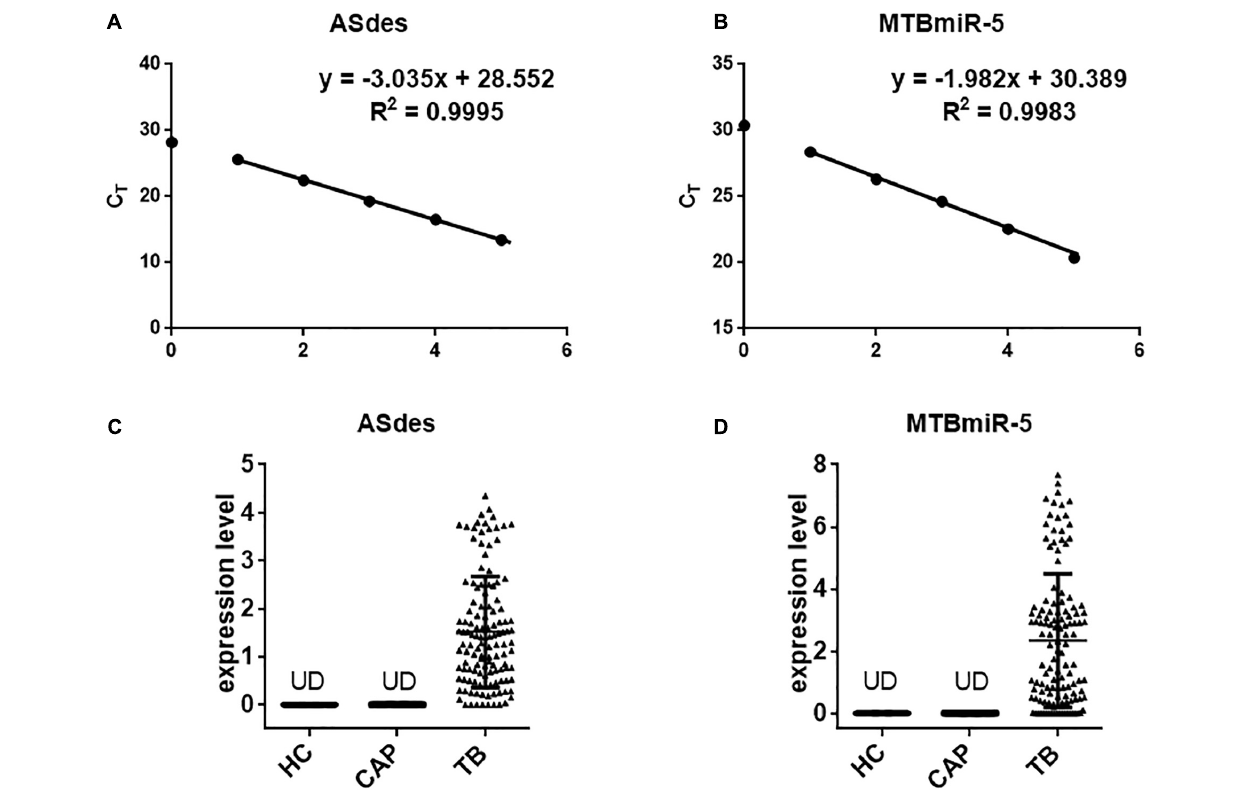
FIGURE 2 | The changes in concentrations of serum exosomal M. tuberculosis -encoded ASdes and MTB-miR5. (A,B) Dynamic range and sensitivity of the qRT-PCR assay for measuring ASdes (A) and MTB-miR5 (B) . Synthetic single-stranded sRNA was serially diluted over several orders of magnitude to levels ranging from 10 attomole to 105 attomole and assessed by the qRT-PCR assay. The resulting CT values were plotted against the index with base 10 of the amount of input sRNA to generate a standard curve. An assay using water instead of RNA for the qRT-PCR assay was included as a no-template control. (C,D) The expression level (pmol per 1 L of serum) of ASdes (C) and MTB-miR5 (D) in the small extracellular vesicle isolated from serum of healthy controls (HC), active pulmonary TB patients (TB) and community acquired pneumonia (CAP) patients.